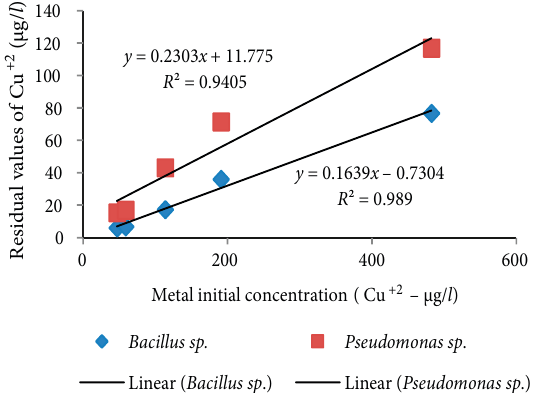
Fig. 2. Relationship between the initial concentration and residual values of Cupper (Cu 2+ )